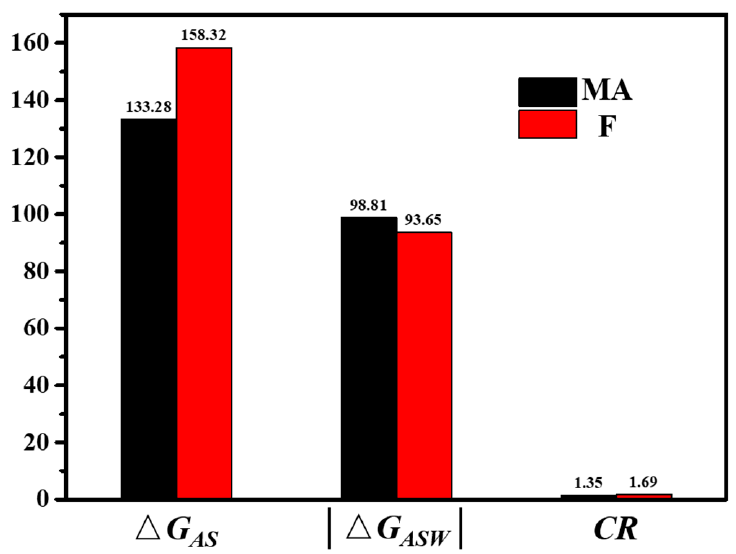
Figure 8. The △ G AS , │△ G ASW │ and CR of MA and F.